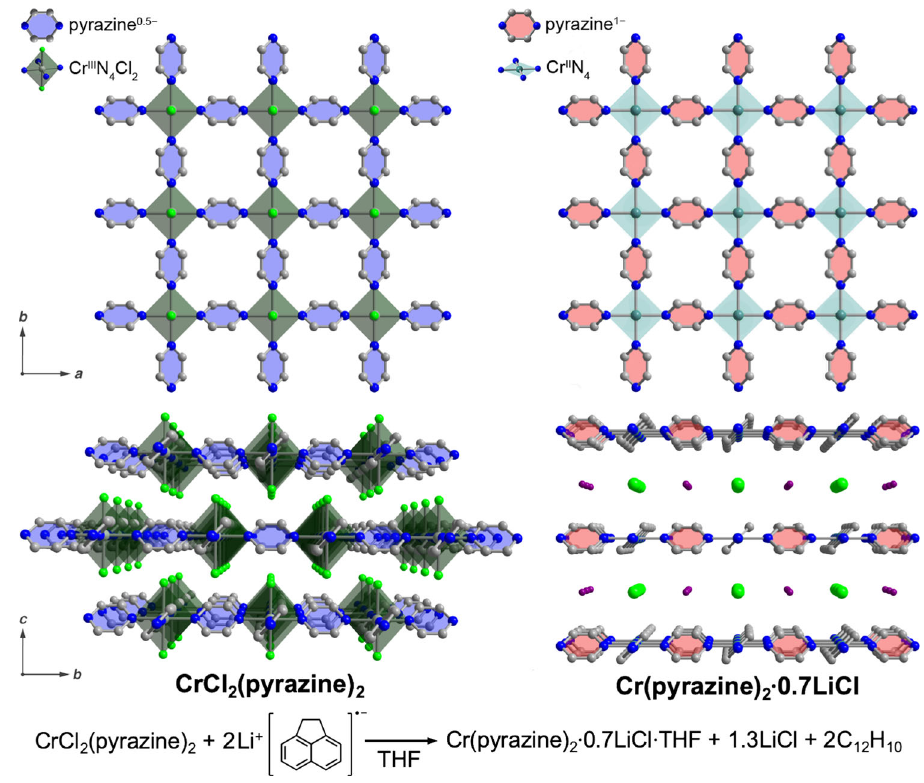
Fig. 2 Reductive insertion chemistry in 2D chromium – pyrazine frameworks. Chemical reaction for the reduction of CrCl 2 (pz) 2 to the high-temperature magnet Cr(pz) 2 , and corresponding crystal structures obtained from X-ray diffraction. Li and Cl atoms are disordered and are modeled with site occupancies of 0.70 and 0.35, respectively.